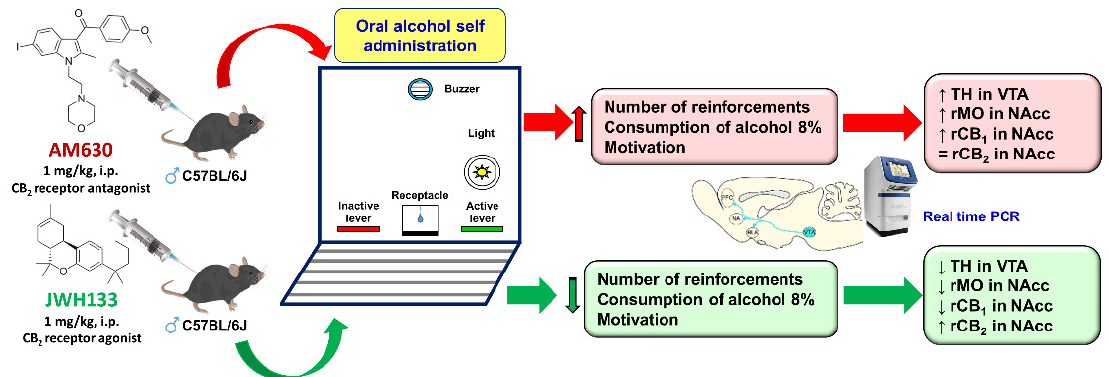
Figure 2. Representative picture of the experimental procedure and the main findings obtained with pharmacological modulation of CB2 receptors (CB2r) in the oral ethanol self-administration paradigm. Image adapted from Navarrete et al. Biochemical Pharmacology (2018) 157, 227–234.